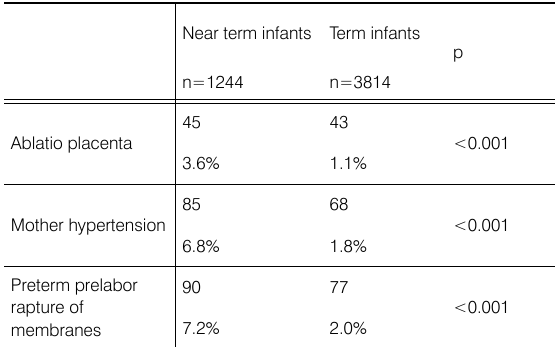
Table 2. The indications associated with cesarean section in late preterm gestation and term gestation